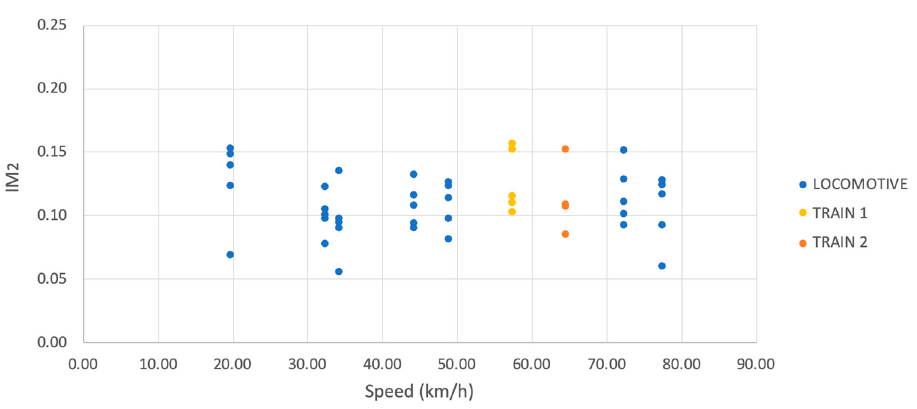
Figure 15. IM 2 calculated for all of the passages of all trains in all the points.